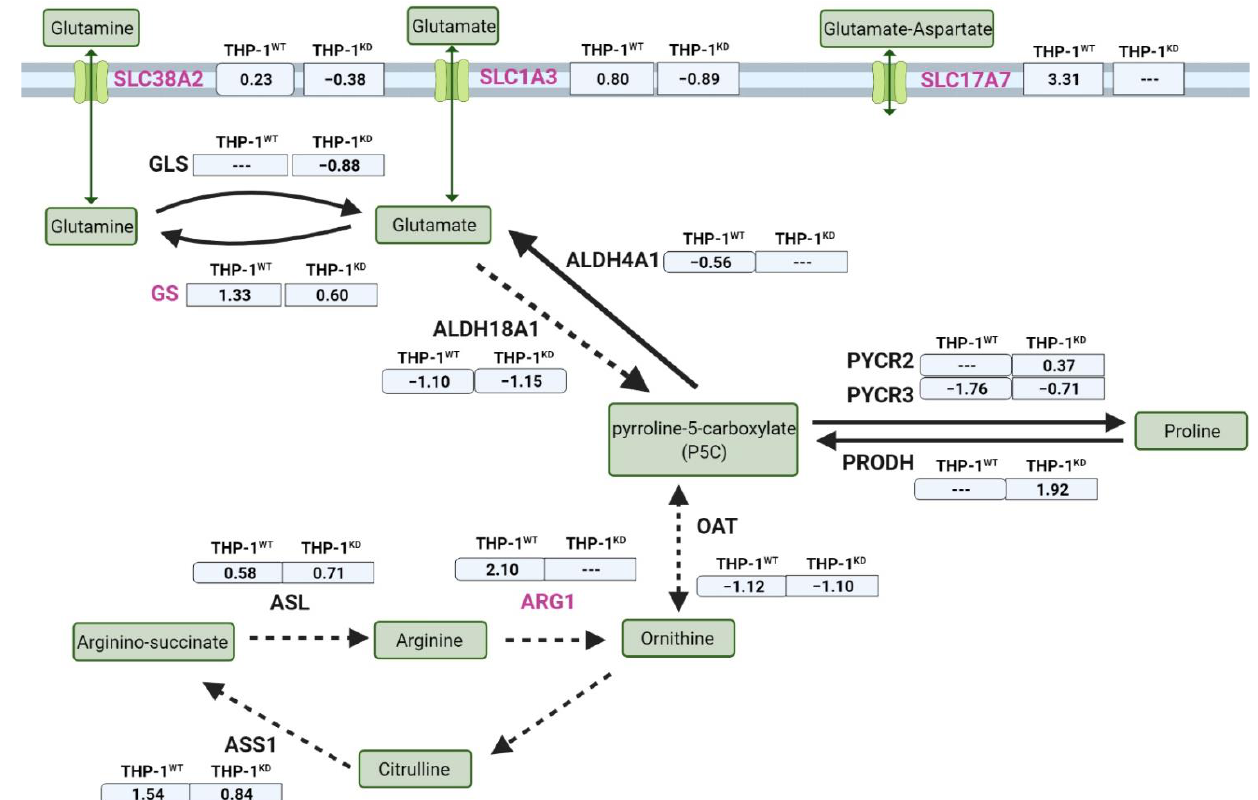
Figure 5. Gene expression alterations of key players in glutamine and glutamate metabolism and transport between THP-1 WT and THP-1 KD in hypoxia. Significant changing genes due to TKTL1 high- lighted in pink. Expression changes in normoxia versus hypoxia, indicated in log2-fold-change for n = 3 samples per condition. Abbreviations: ALDH — aldehyde dehydrogenase family, ALDH4A1 —